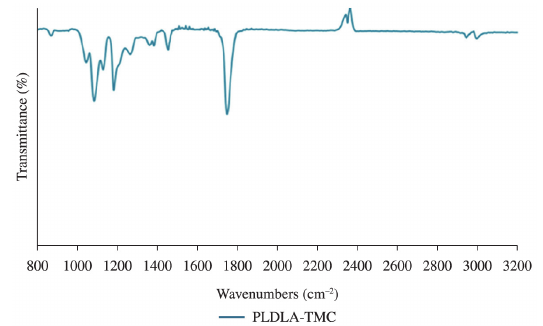
Figure 6. FTIR spectra of